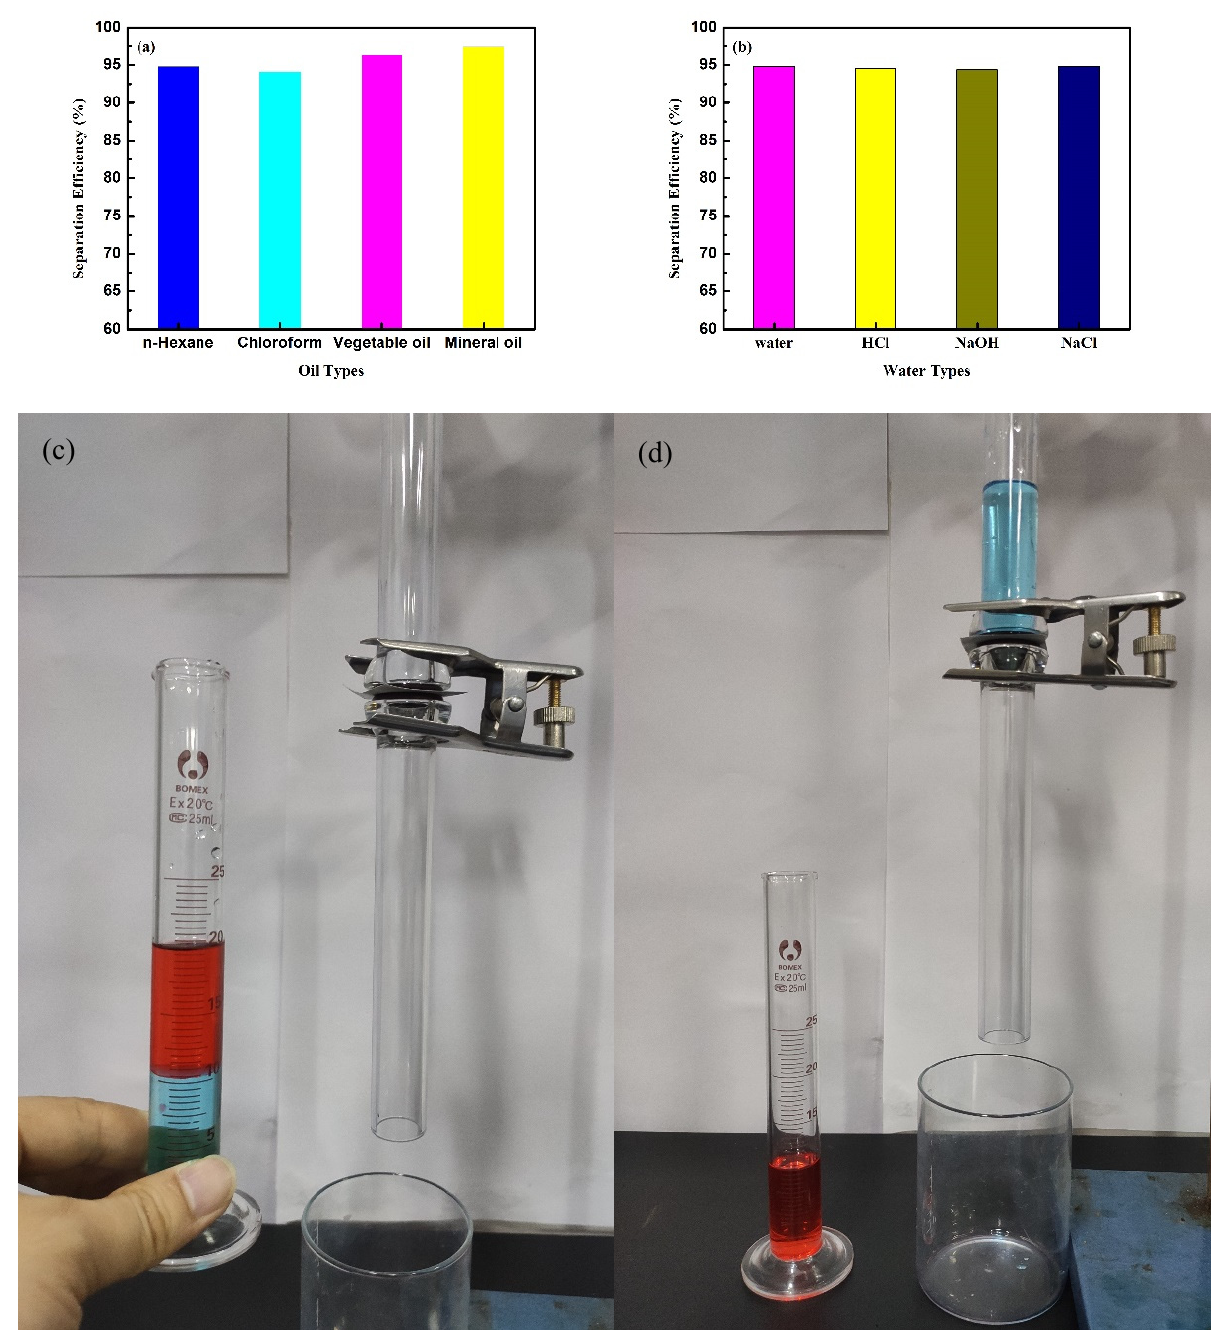
Figure 6. Oil–water separation efficiency and device of coated mesh: different oil–water mixture ( a ), oil–water mixture with different pH values ( b ), the device of oil–water separation ( c , d Table 1. Comparison of the SSM and some reported separation materials.